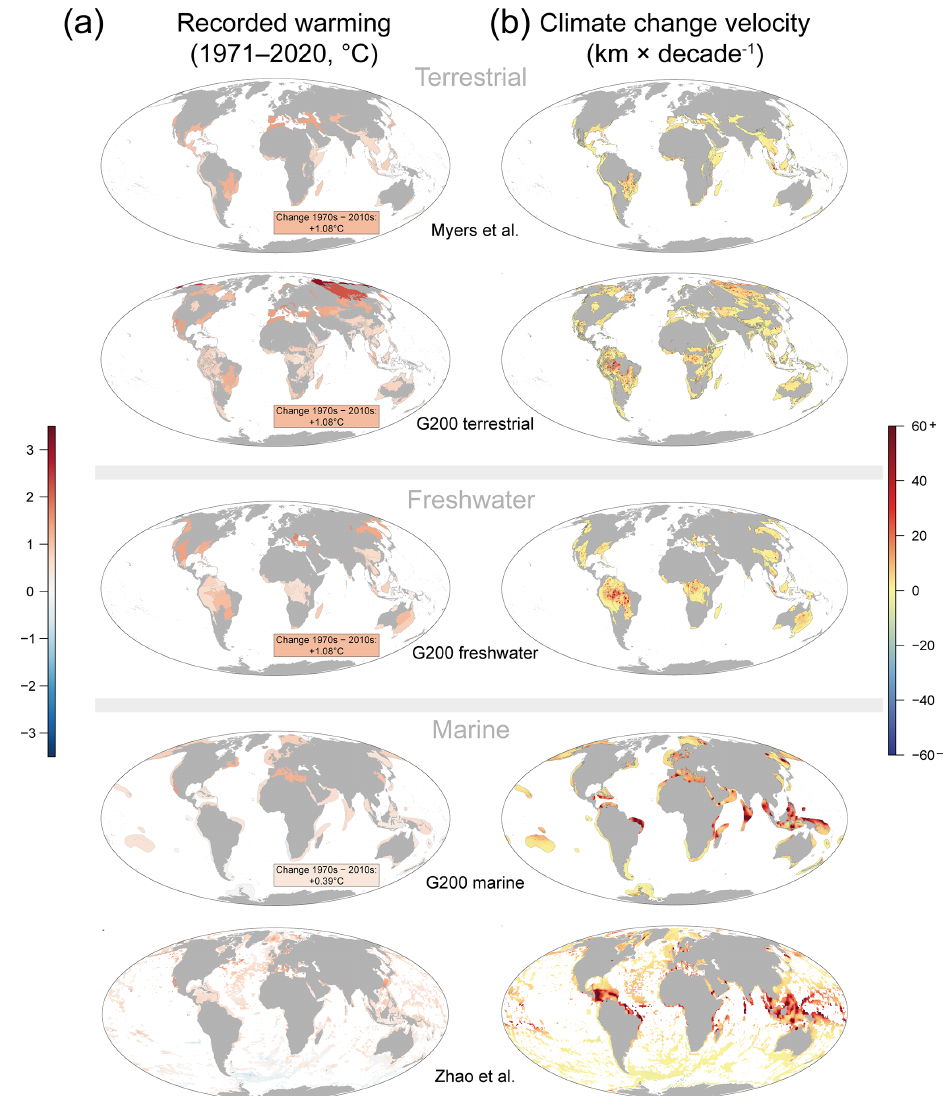
Figure 1. Recorded global warming in the terrestrial, freshwater, and marine environments in the past 50 years. (a) The mean absolute changes ( ◦ C) in rich spots between the average annual means between the 1971–1980 interval and the 2011–2020 interval. (b) Spatial distribution of climate change velocities (kilometres per decade). Terrestrial and freshwater rich spots are assessed with near-surface air temperatures, and ocean surface temperatures were used with marine rich spots. Note the high spatial variability of climate change